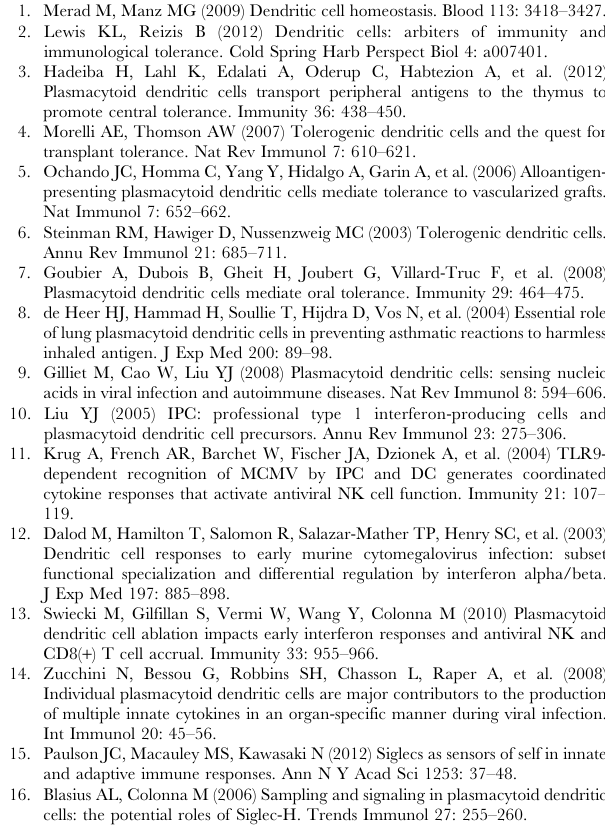
Figure S1 Construct design of the pDCre mouse by targeting the Siglec-H promoter with BAC gene technol- ogy. Shown here is the design of the Siglec-H BAC construct displaying the recombination site within the Siglec-H exon 1 locus. Mice carrying this construct expressed Cre recombinase under the influence of the Siglec-H promoter and were further bred to floxed RFP reporter utilizing the ubiquitous Rosa 26 promoter to generate the pDCre x RFP reporter mice. Figure S2 Reporter expression in early dendritic cell precursors and CD9 + pDC. ( A ) Shows an in vitro CDP differentiation assay from CFSE labeled BM from pDCre x RFP mice or littermates analyzed on day 3 of Flt3-L culture based on a protocol from Naik et al. [28]. Ly-6G, MHCII, CD19, and CD127 were excluded in a default channel. Pro-DCs were gated as CFSE low CD11c 2 and pre-DCs as CFSE low CD11c + . Representative FACS plots showing Siglec-H (or isotype control) staining versus RFP reporter expression from one out of two independent experiments. ( B ) CD9 expression by BM pDCs from pDCre x RFP mice or littermates gated as Siglec-H + CD11c int from one out of two independent experiments.